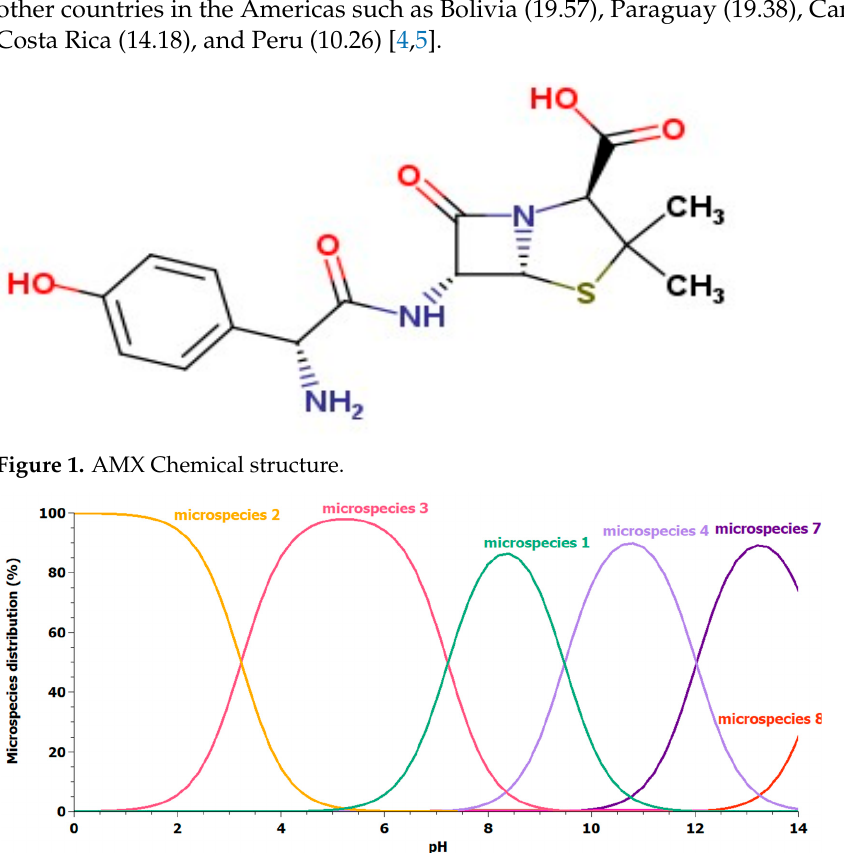
Figure 2. Speciation of AMX as a function of pH in aqueous solutions. The chemical structure of each microspecies is shown in the Supplementary Materials (Figures S1–S8).